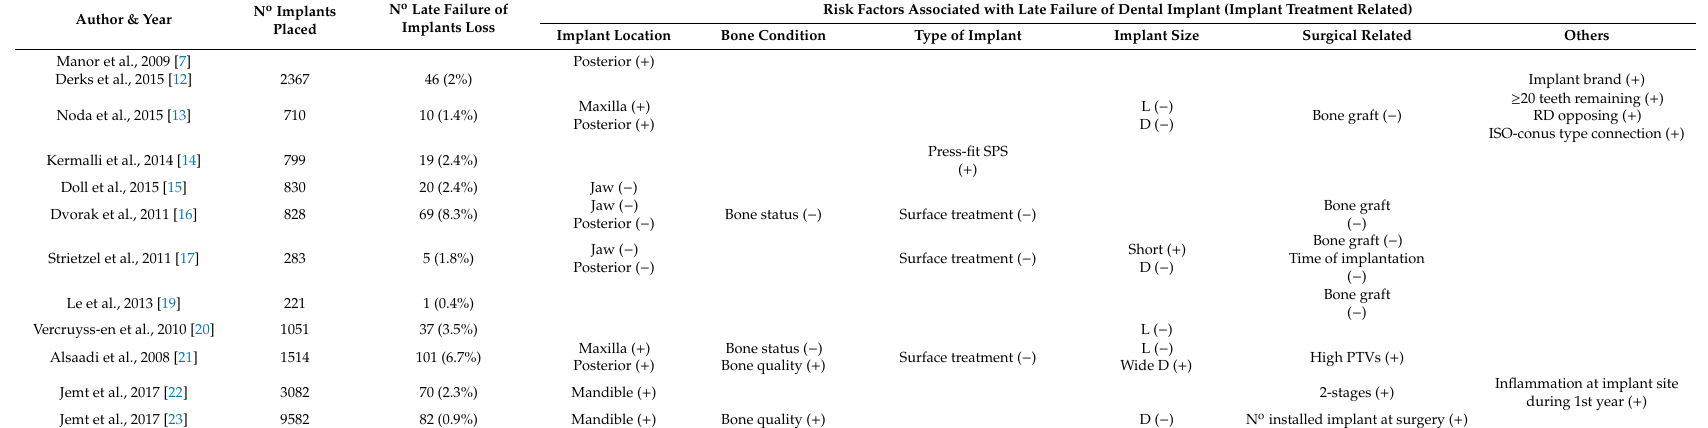
Table 2. Studies that have evaluated the risk factors associated with late dental implant failure (part